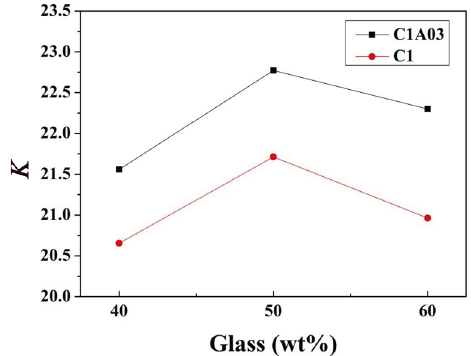
Fig. 7 Dielectric constants of Ca 0.7 Nd 0.2 TiO 3 added with various amounts of C1 and C1A03 glasses after sintering at 900 ℃ . Table 2 Q × f values (at 7 GHz) of Ca 0.7 Nd 0.2 TiO 3 added with C1 and C1A03 glasses after sintering at 850 and 900 ℃ Glass addition Glass